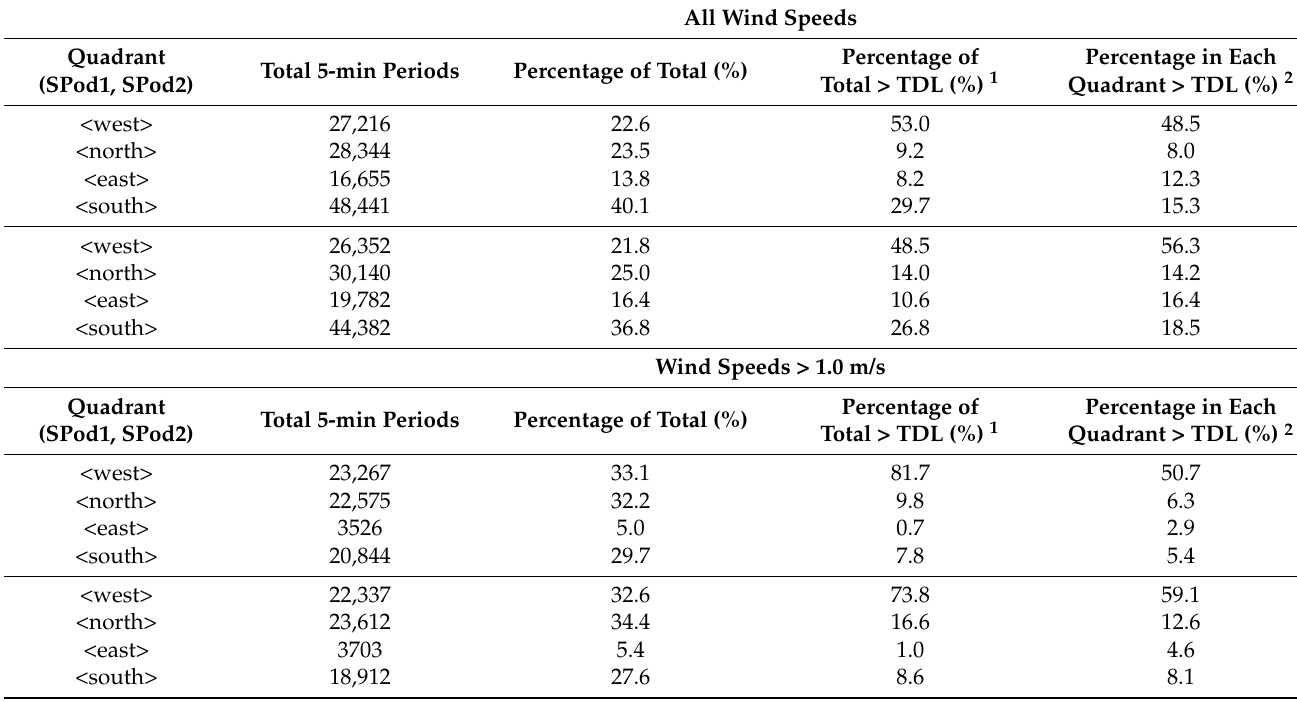
Table 2. SPod QA-valid and paired data, 45-degree rotated quadrant analysis, (top panel) All data; (bottom panel) subset of data above 1 m/s wind